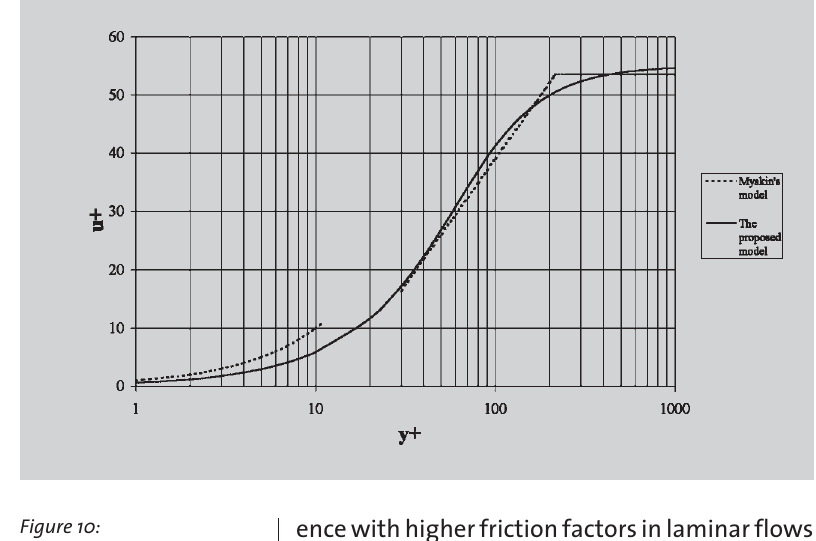
Figure 10: The comparison of the pro- posed model to Myskin’s model for